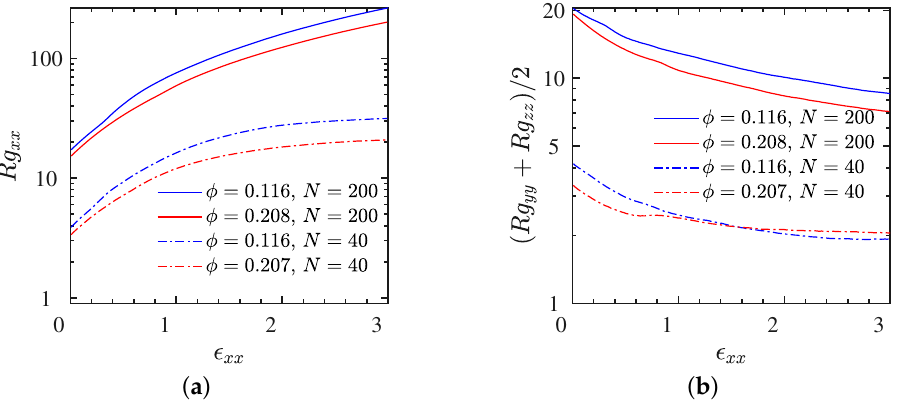
Figure 7. Polymer structure during stretching for different NP loadings and chain lengths for all weakly electrostatic L ◦ and S ◦ systems ( ε r = 50). Different elements of gyration tensor, ( a ) parallel- and ( b ) perpendicular to the direction of strain. Data correspond to the strain rate of ˙ (cid:101) xx = 0.01. A similar trend was observed for strongly electrostatic systems L • and S • but with a slight increase (less than 10%) in gyration tensor elements (results not shown here). Additional data highlighting the effect of strain rate provided in Figures S4 and